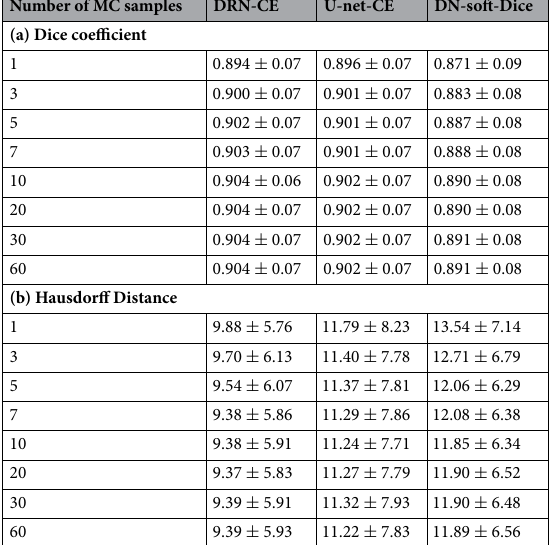
Number of MC samples DRN-CE